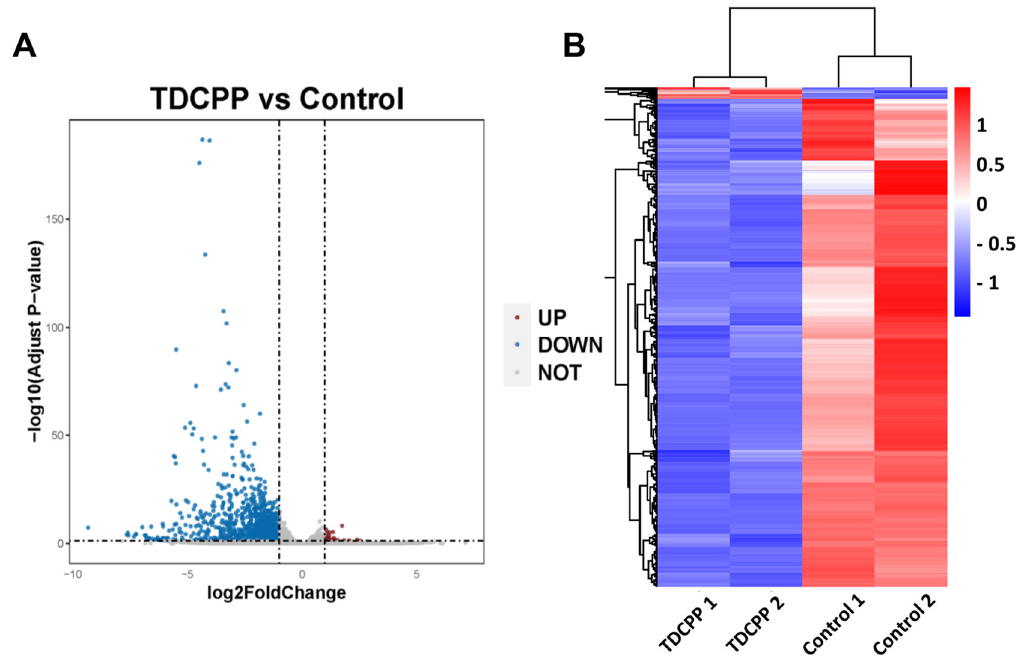
Figure 4. RNA-Seq analysis of mice spleen tissue. ( A ) DEGs were analyzed and volcano plots were drawn for mice treated with different doses of TDCPP. ( B ) Hierarchical clustering heat maps were plotted for DEGs between the control and TDCPP groups, and increases in expression are indicated in red, while decreases are indicated in blue.